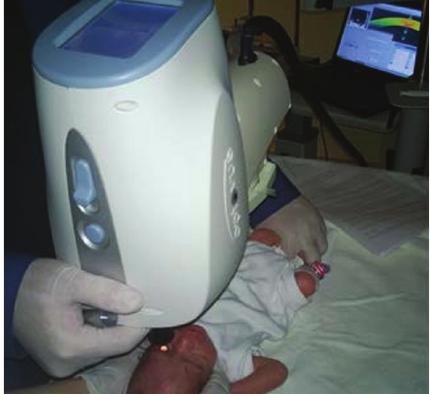
Figure 1: Measurement of CCT by SD-OCT in a premature